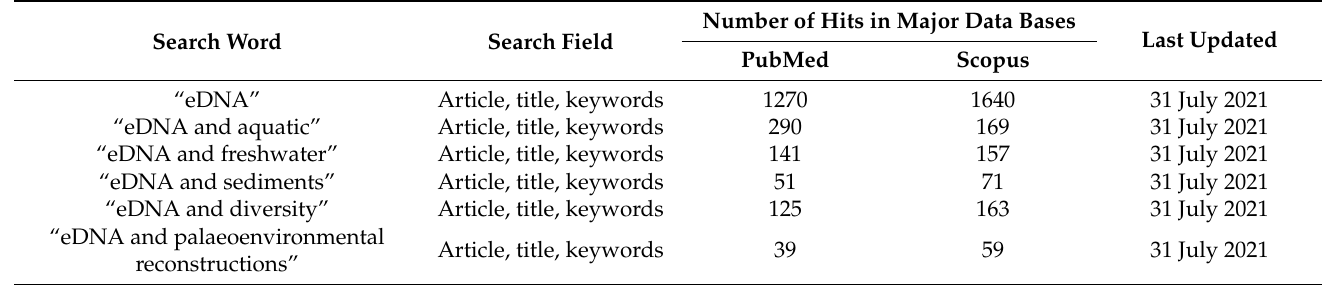
Table 1. Literature search based on specific keywords utilizing scientific